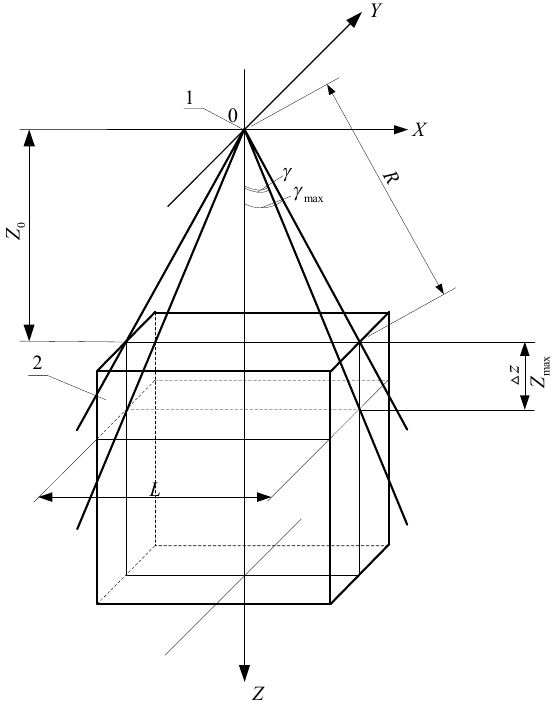
Fig 1. The scheme of acoustic scenery formation: 1 – antenna grating; 2 –